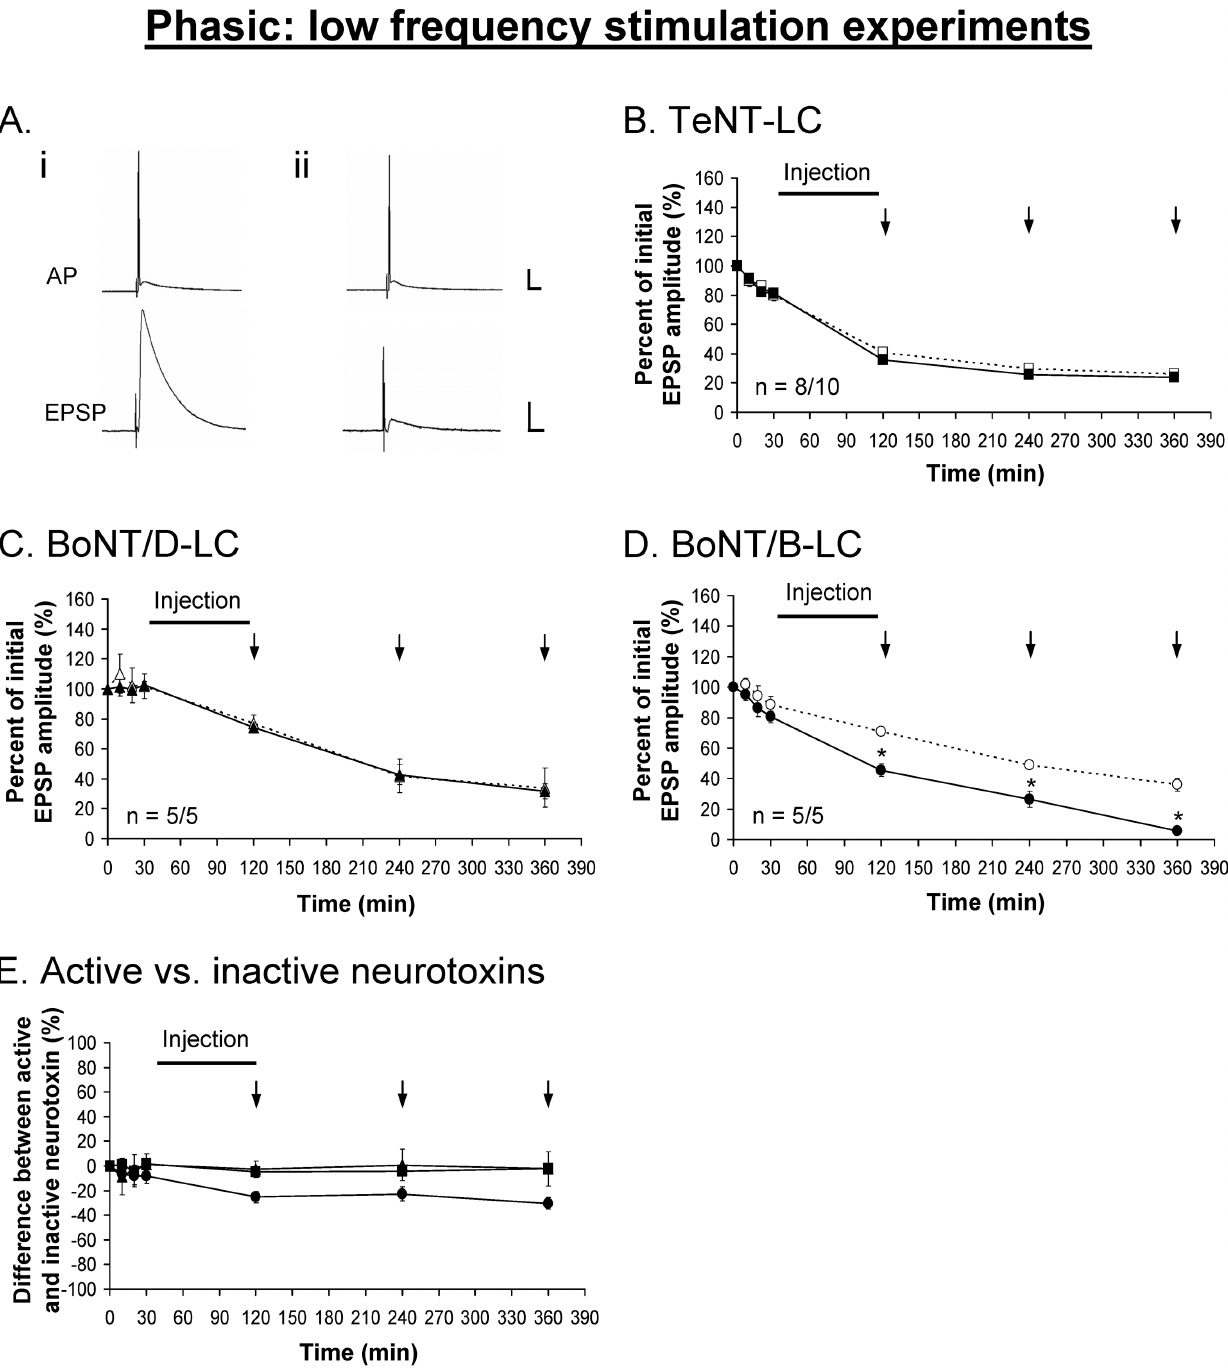
Figure 3. Phasic EPSPs are inhibited using BoNT/B-LC under low frequency stimulation. A , Example showing the phasic action potential (AP) remains unchanged before ( i ) and after ( ii ) the injection of each neurotoxin (BoNT/B-LC used as the example). TeNT-LC ( B ) and BoNT/D-LC ( C ) did not have an effect on the phasic evoked response. E , Percent difference between active and inactive neurotoxin, in which the inactive neurotoxin is N the reference point at 0%. In B-E , a solid black line represents the time course of neurotoxin injection (90 min) and vertical arrows ( Q ) represent when ). Inactive neurotoxins: TeNT-LC ( % ), BoNT/D-LC ( g ) and EPSPs were recorded. Active neurotoxins: TeNT-LC ( & ), BoNT/D-LC ( m ) and BoNT/B-LC ( BoNT/B-LC ( # ). Error bars represent S.E.M. An asterisk (*) denotes a significant difference (p , 0.05) and ‘n’ represents sample size (active/inactive neurotoxin). Scale bars: horizontal – 10 ms; vertical – 10 mV (AP), 5 mV (EPSP). doi:10.1371/journal.pone.0095130.g003 of NT release in 1.5 hours but 43% of the VAMP immunoreac- The cleavage of VAMP separates its transmembrane domain from its cytosolic domain. This will still allow the cytosolic domain tivity remained [40]. containing the SNARE binding motif to interact with the t-